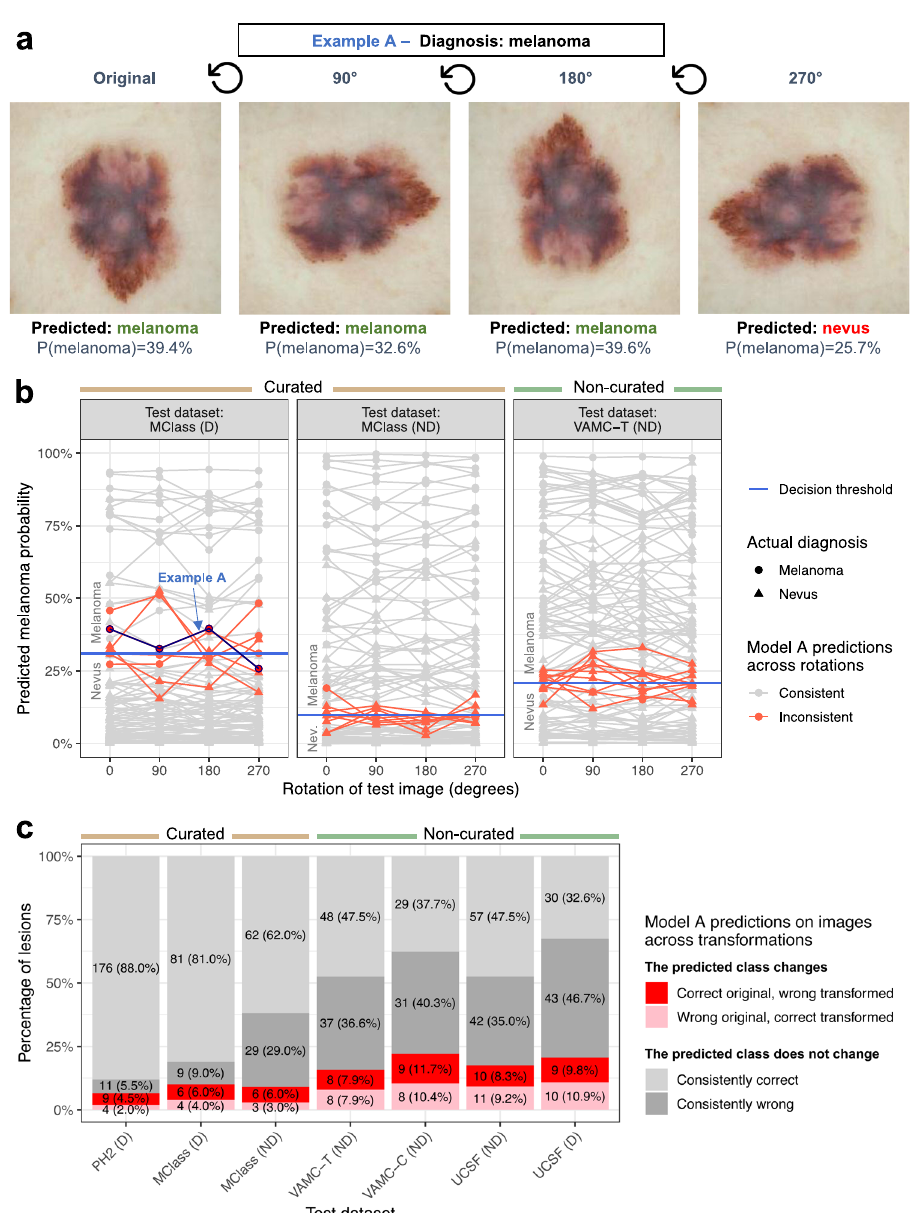
Fig. 4 Dermatologist-level CNN models are not robust to image transformations. a Representative example of Model A predictions on a melanoma image from MClass-D. The predicted probability of melanoma is shown below the predicted class. The decision threshold is model con fi dence >31.0%, as determined by the operating point at which the model has a sensitivity comparable to dermatologists for the MClass- D. b The predicted melanoma probability across rotations is plotted for each example for each test set. Non-robust images whose predictions cross the decision threshold, selected to match dermatologists ’ sensitivity, are plotted in red, robust predictions plotted in gray. The false negative example shown in ( a ) is highlighted by the blue arrow. c The percentage of non-robust lesions, assessed over rotations, horizontal fl ip, brightness, and contrast transformations, is shown as a percentage of the whole dataset for each test dataset. “ Consistently correct ” and “ Consistently wrong ” refer to lesions whose prediction is consistent across all transformations. “ Correct original, wrong transformed ” refers to lesions whose prediction was correct on the original image but was wrong on one or more transformed images. “ Wrong original, correct transformed ” refers to lesions whose prediction was wrong on the original image but was correct on one or more transformed images. Abbreviations: D Dermoscopic, MClass Melanoma Classi fi cation Benchmark, ND Non-dermoscopic, PH2 Hospital Pedro Hispano, UCSF University of California, San Francisco, VAMC-C Veterans Affairs Medical Center clinic, VAMC-T Veterans Affairs Medical Center